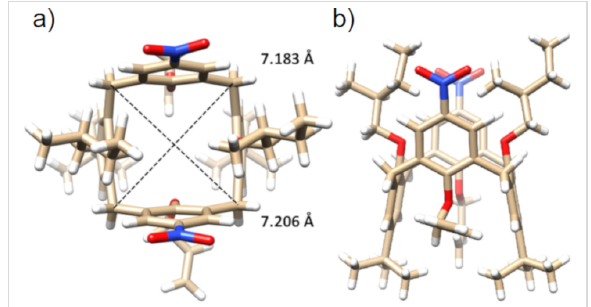
Figure 2: X-ray structure of 4a : (a) Top view into the cavity. (b) Side view of the same cavity.